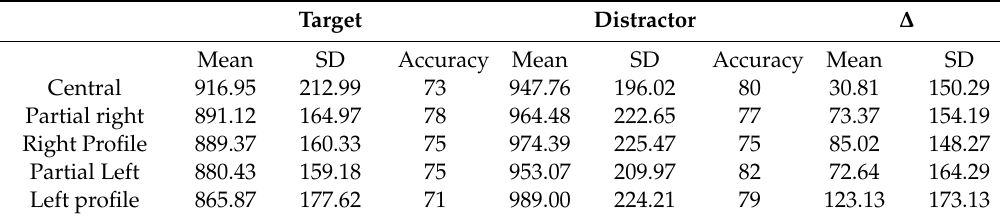
Table 1. Mean and SD (standard deviation), increases ( ∆ ) and e ffi cacy (%) in the fifth